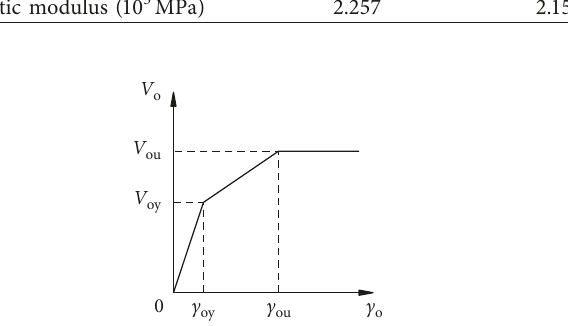
Figure 3: Trilinear shear force-deformation